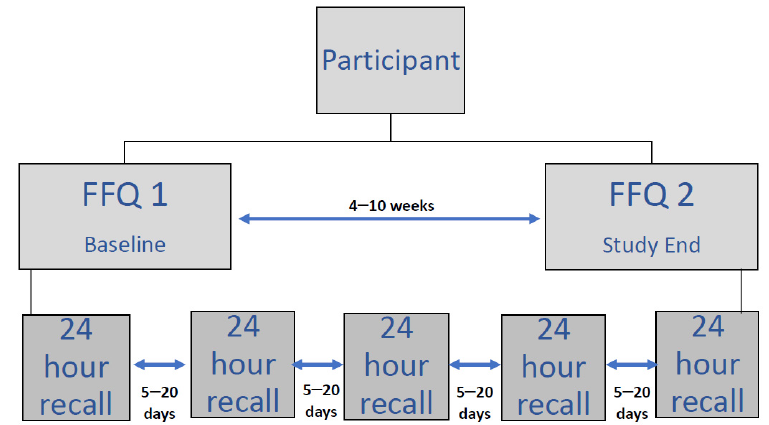
Figure 1. Study design. FFQ: Food frequency questionnaires.